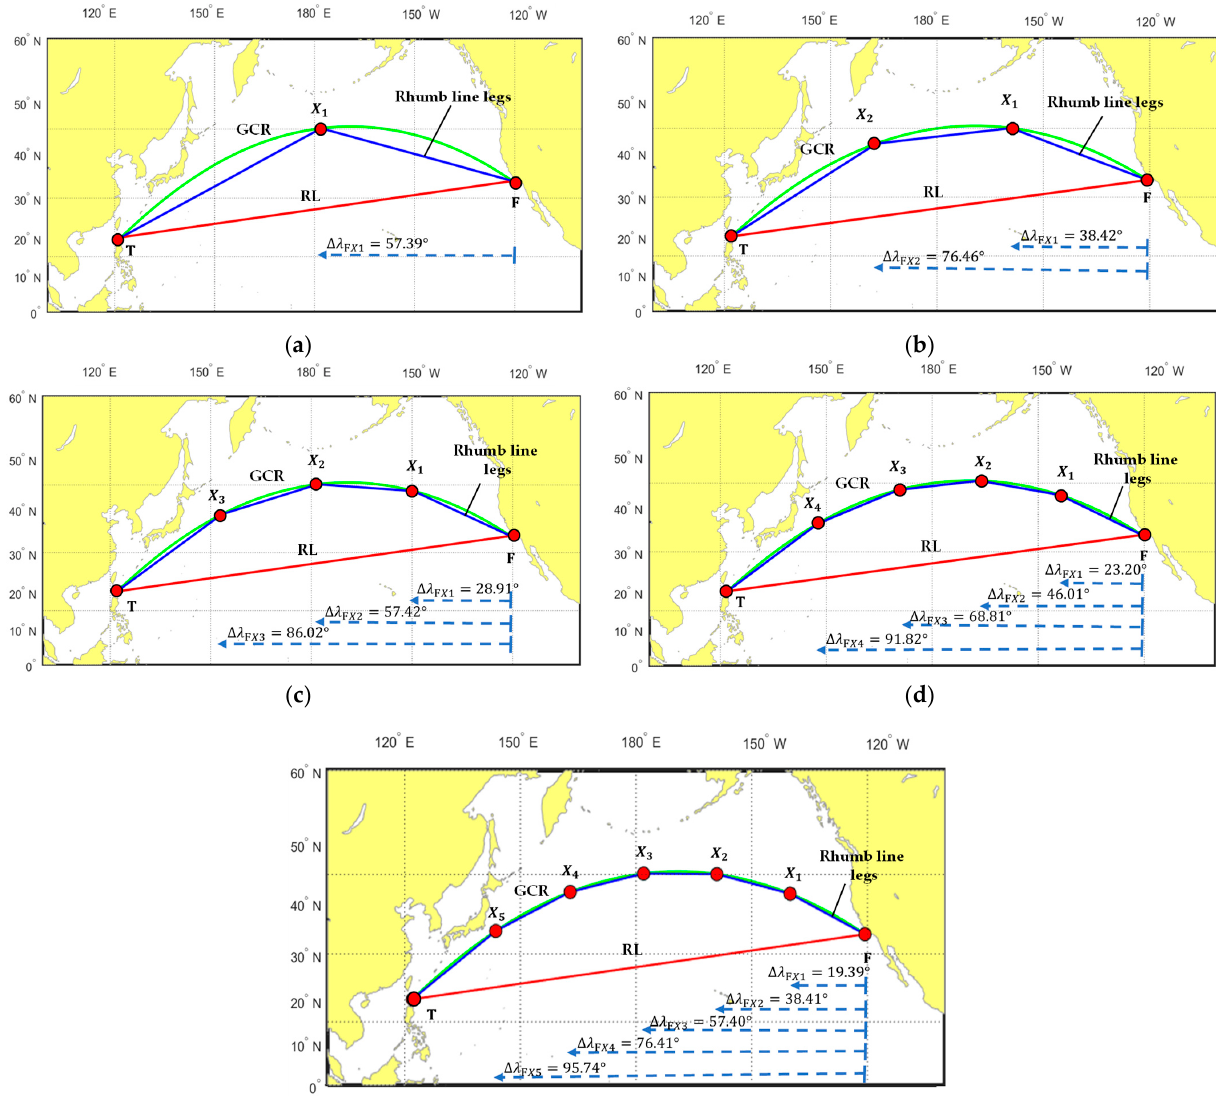
is ∆ λ F X 1 = 23.20 ◦ , ∆ λ F X 2 = 46.01 ◦ , ∆ λ F X 3 = 68.81 ◦ , and ∆ λ F X 4 = 91.82 ◦ , as shown in Figure 6d. The RB value of 16.02 nm is still greater than 15 nm, and a new waypoint should be added. When the n = 5, the termination condition is reached after 330 iterations, and the optimal solution is ∆ λ F X 1 = 19.39 ◦ , ∆ λ F X 2 = 38.41 ◦ , ∆ λ F X 3 = 57.40 ◦ , ∆ λ F X 4 = 76.41 ◦ , and ∆ λ = 95.74 ◦ , as shown in Figure 6e. The RB value of 11.13 nm becomes less than 15 nm, F X 5 and the process is stopped. The optimal position distributions of five waypoints obtained by decoding were: X 1 (41 ◦ 38.4 (cid:48) N, 140 ◦ 03.0 (cid:48) W), X 2 (45 ◦ 03.6 (cid:48) N, 159 ◦ 04.2 (cid:48) W), X 3 (45 ◦ 09.0 (cid:48) N, 178 ◦ 04.2 (cid:48) W), X 4 (41 ◦ 57.6 (cid:48) N, 162 ◦ 55.2 (cid:48) E), and X 5 (34 ◦ 38.4 (cid:48) N, 143 ◦ 36.0 (cid:48) E).